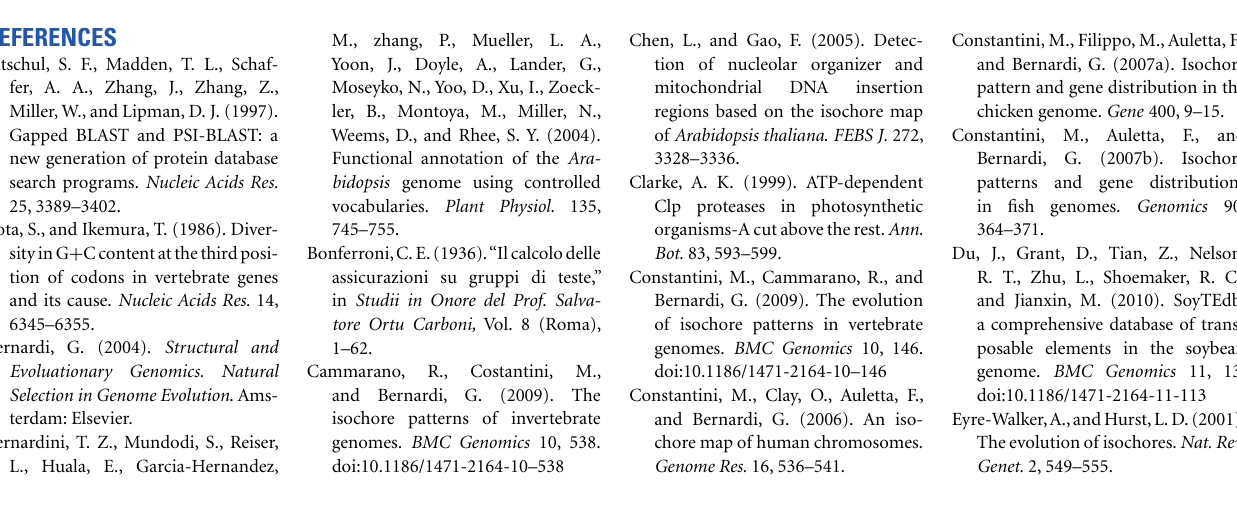
Table S1 |The coordinates of the LHGRs in